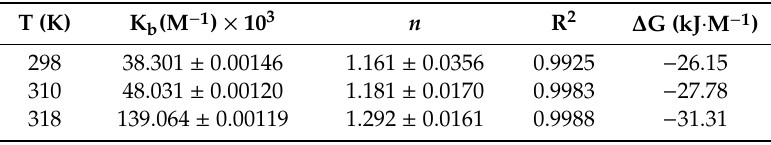
Table 2. Thermodynamic binding parameters of the AICAR–HSA complex.